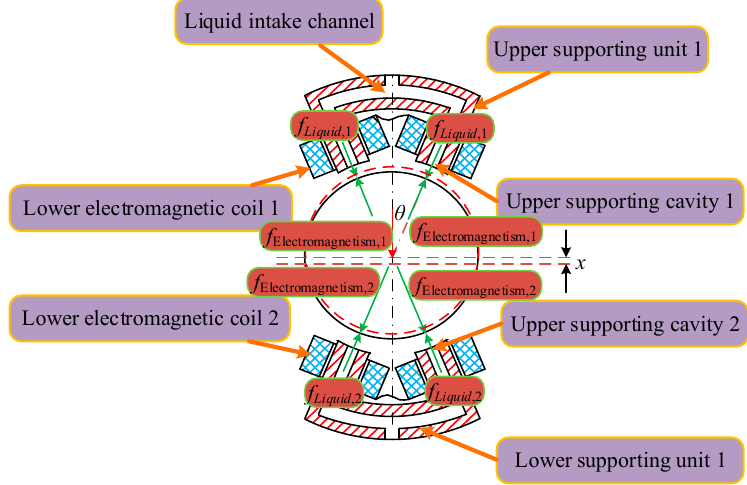
Figure 3. The force diagram of single degree of freedom radial magnetic bearing.